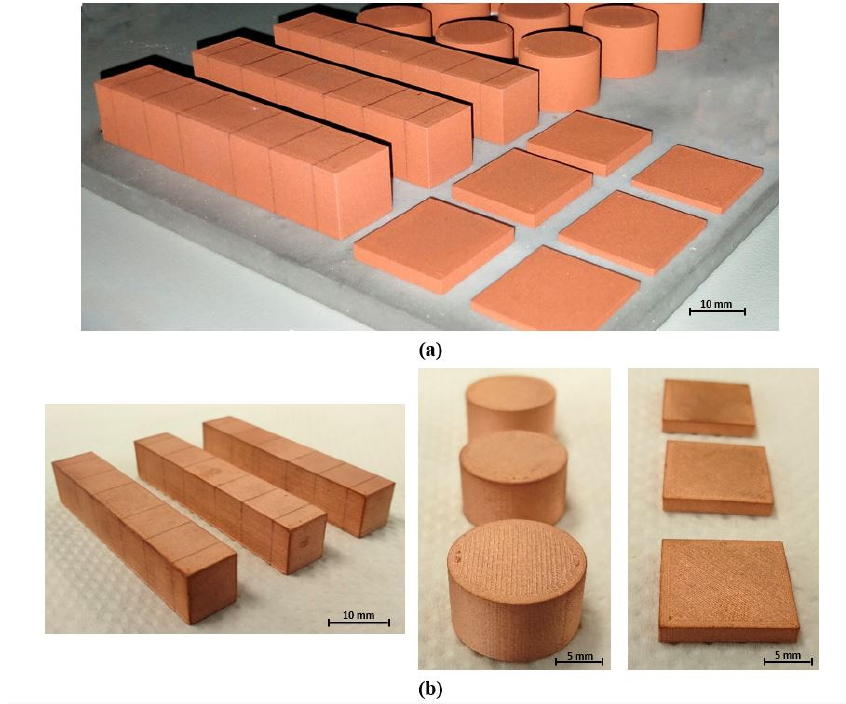
Figure 5. Copper parts manufactured by Metal Extrusion Additive Manufacturing. ( a ) Green parts after printing stage. ( b ) Final sintered